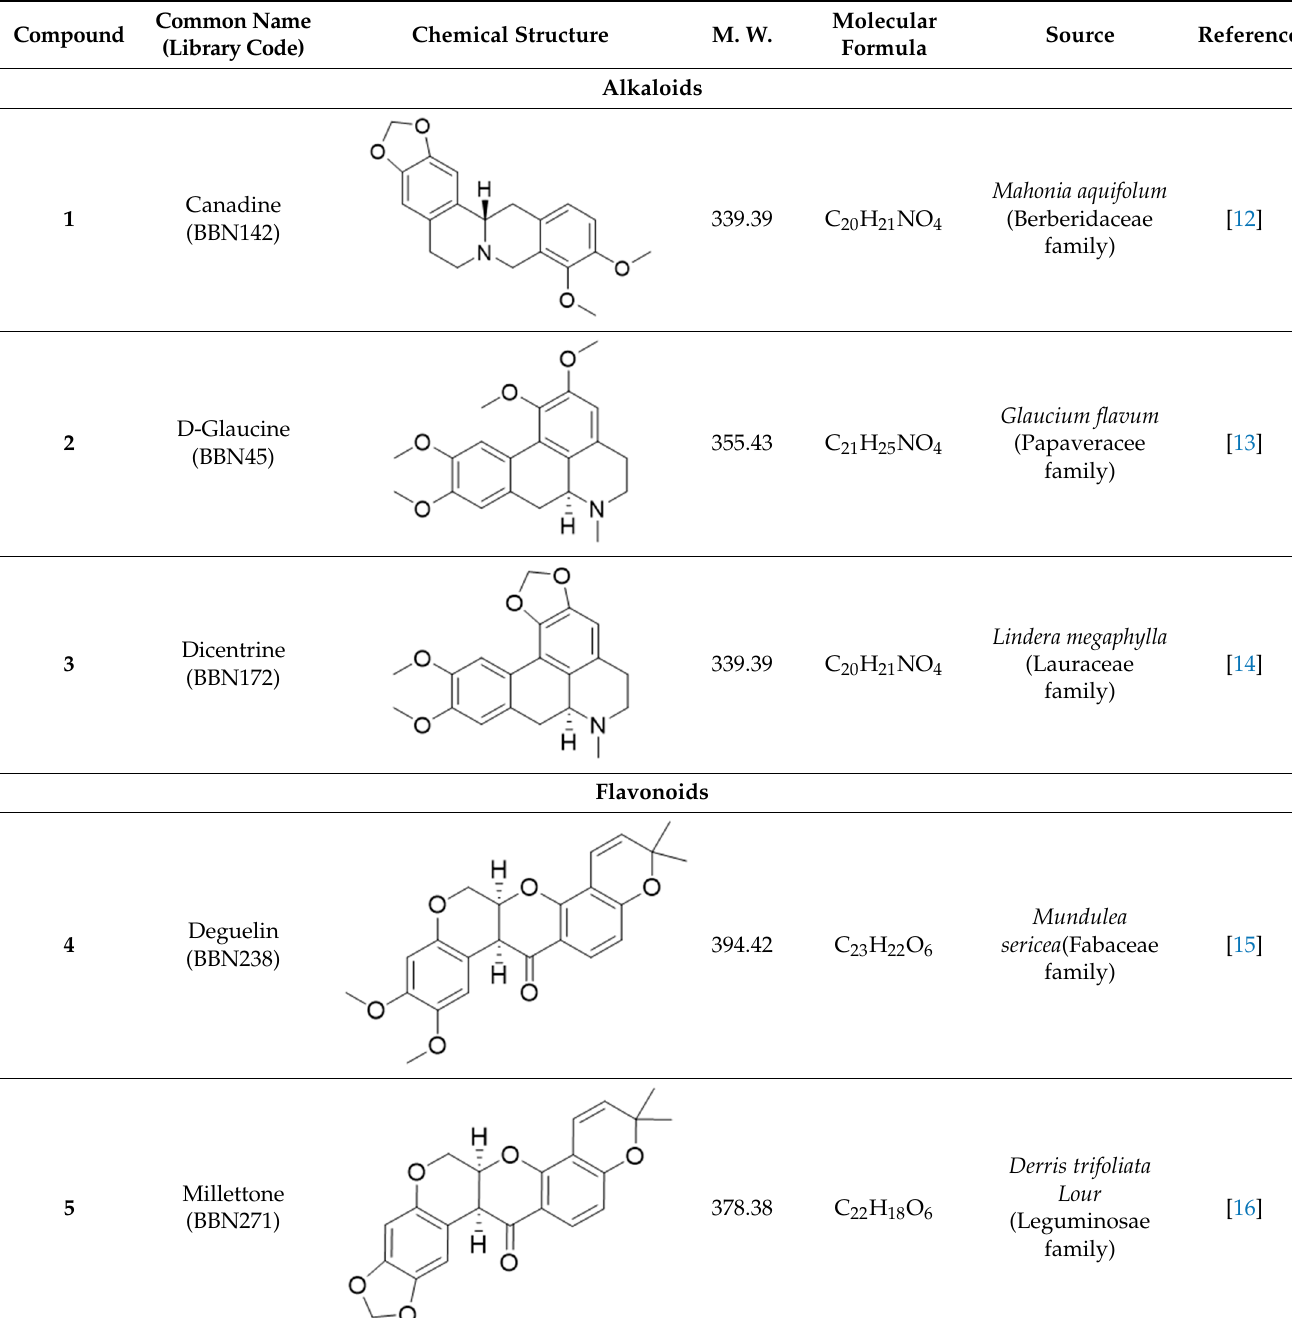
Table 1. Chemical structures and features of the natural alkaloids Canadine, D ‐ Glaucine and Di ‐ centrine and the flavonoids Deguelin and Millettone.